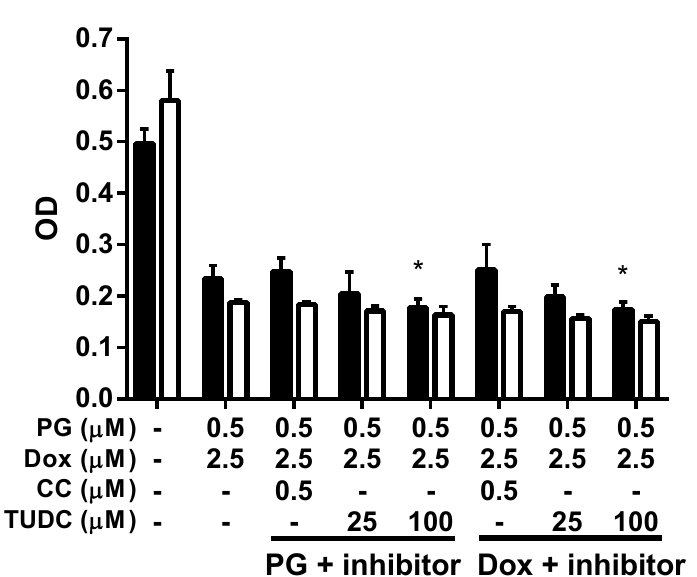
Figure 7. Cell viability change when PG/Dox combined with ER stress and energy deprivation inhibitors. OSCC cells were treated with PG + inhibitor/Dox or PG/Dox + inhibitor and were analyzed for cell viability. The inhibitors contained tauroursodeoxycholic acid (TUDC) and dorsomorphin (compound C, CC). The results were represented as mean ± SD from three individual experiments. * p < 0.05 compared with PG/Dox.